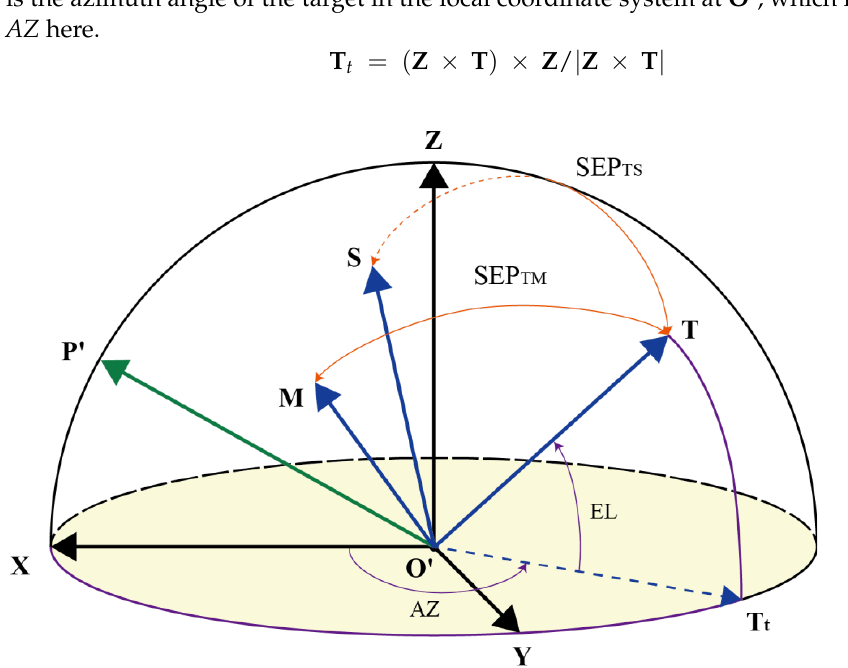
Figure 1. Positions of target, the Sun and Moon in local coordinate system. The observer is at O’ . All vectors are starting at O’ and ending at a unit semi-sphere. X points to the north. Z points to zenith. Y points to west. The local coordinate system is determined by these three vectors. T points to the target. S and M are unit vectors pointing to the Sun and Moon, respectively. SEP TM and SEP TS are separation angles between the target with the Moon and Sun, respectively. The dashed arrow, T t , indicates the unit vector in the direction of the projection of T on the horizontal plane . AZ and EL are the target azimuth and elevation angles, respectively. P’ points to the north celestial pole.